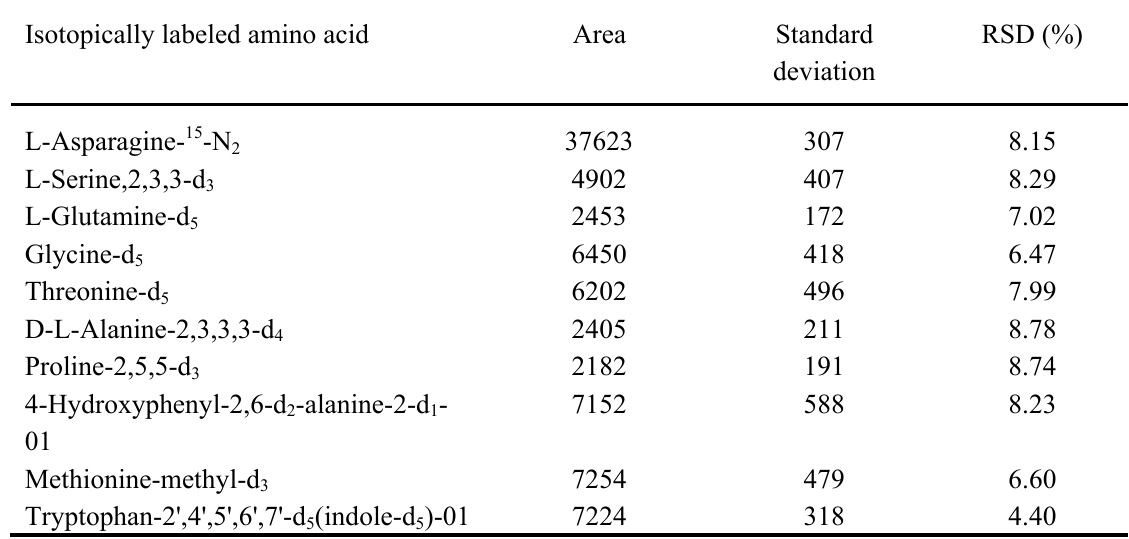
Table S1. Reproducibility of peak areas for AQC-derivatives of isotopically labeled amino acid standards obtained in 50 mM ammonium acetate buffer (pH 9.3). Experimental conditions were the same as described in Section